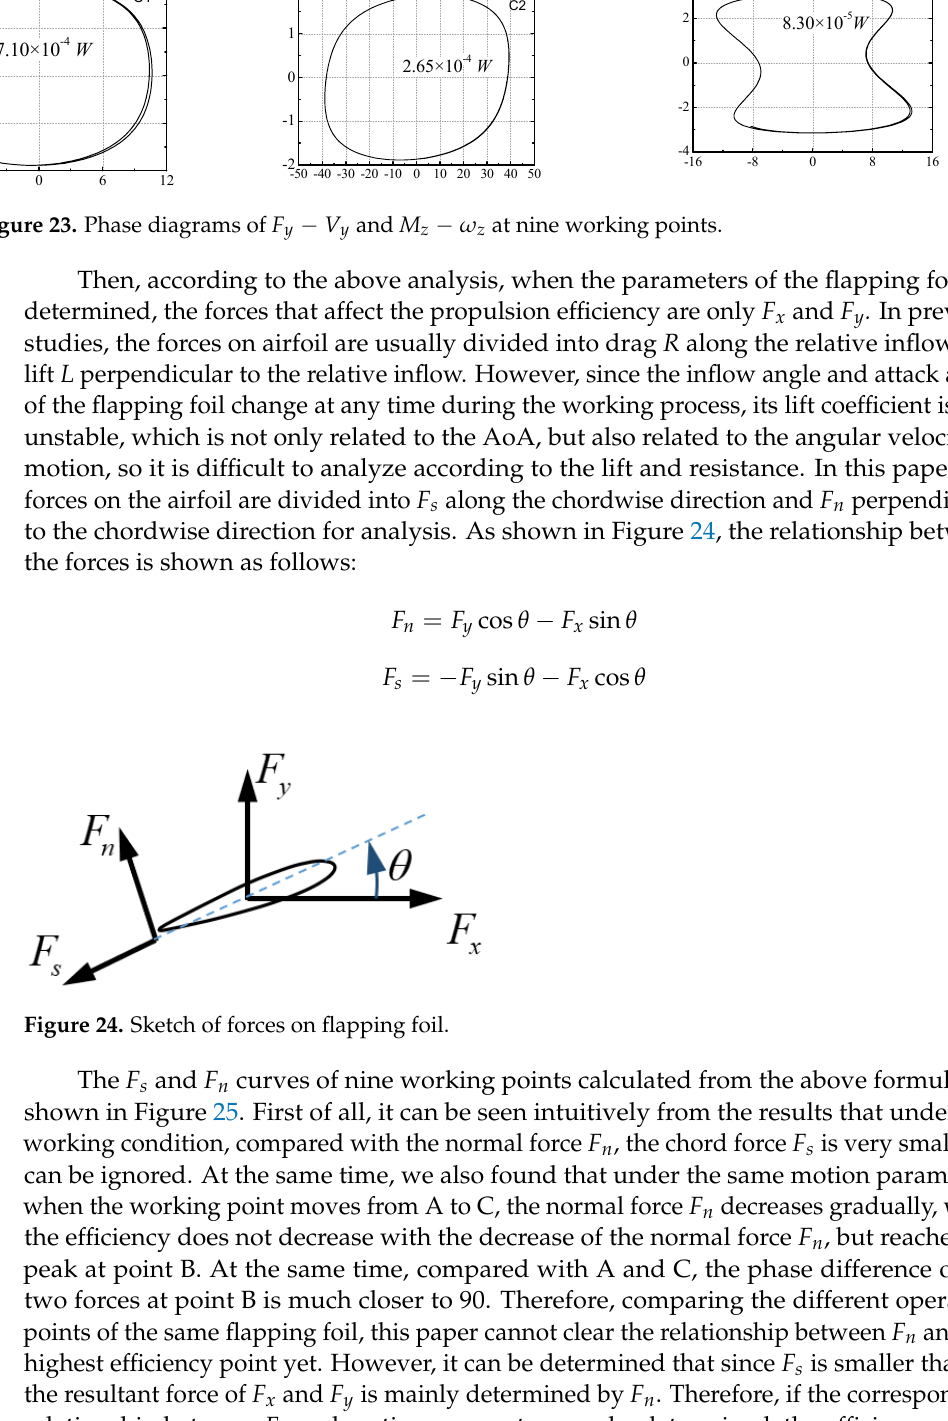
Figure 25. Comparison of Fs and Fn at nine working points.